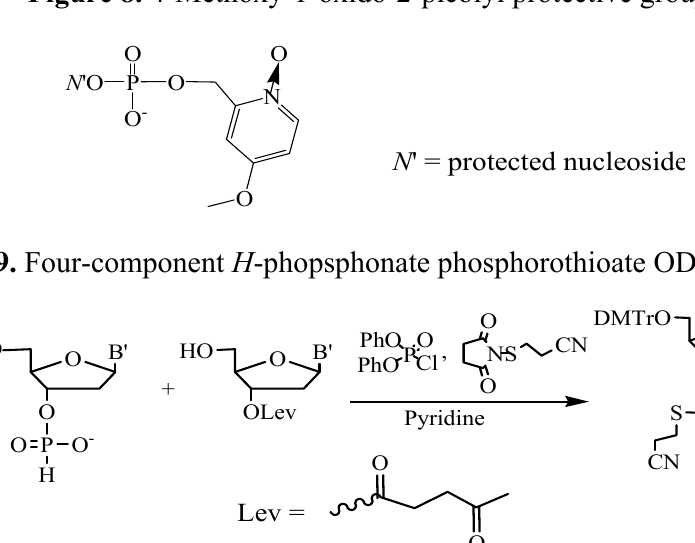
Figure 8. 4-Methoxy-1-oxido-2-picolyl protective group.